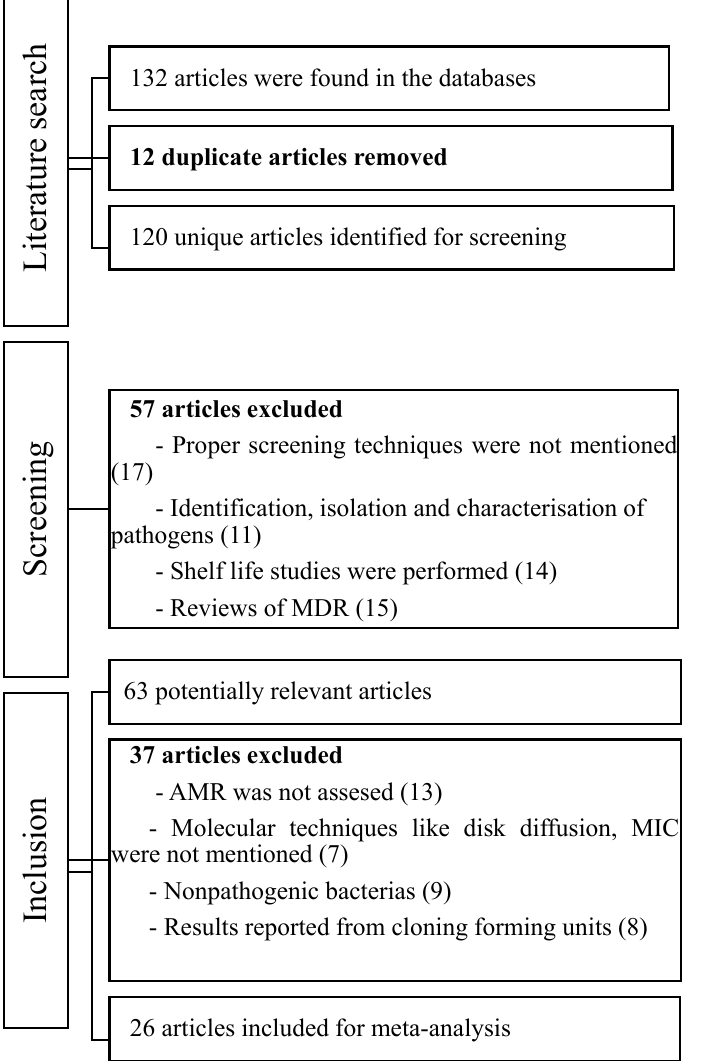
Figure 2. A strategy for identifying, screening, and including articles in meta-analyses from different food sources and their AMR. Out of 26 papers selected, 15 papers were from China [15–29] and the rest (11 papers) were from the USA [30–40]. The data extracted contain 13,018 food samples, out of which 5000 samples were AMR positive (2276 and 2724 from China and the USA, respectively).